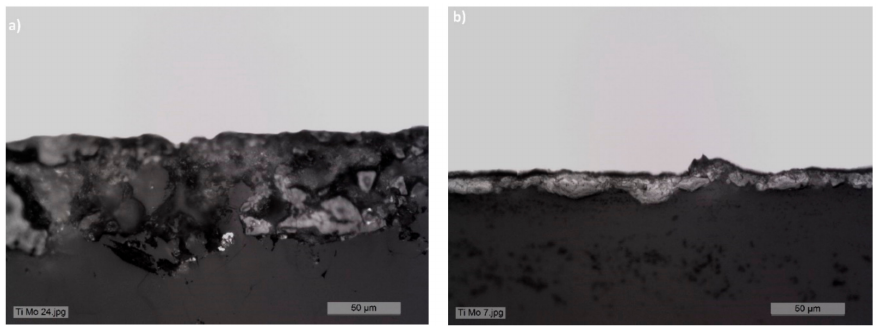
Figure 4. Optical cross-sections of two Ti-15Mo oxidized layers obtained by PEO with the electrolyte of series 9, (Ca/P) sol = 1.12, and (Ca/P) coat = 0.98 ( a ); and electrolyte of series 10, (Ca/P) sol =1.52, and (Ca/P) coat = 0.99) ( b ).